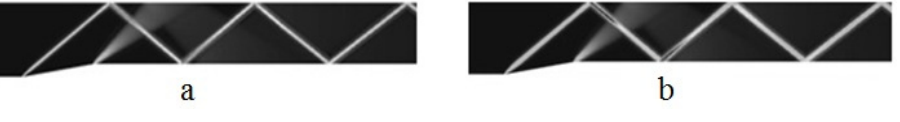
Figure 6. Criterion (5) for density ( a ) and pressure ( b ).